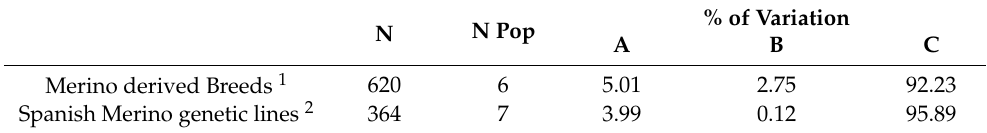
Table 2. Analysis of molecular variance (AMOVA) of the Merino-derived population using genomic data. A (% of Variation between Pop), B (% of Variation between samples within Pop), C (% of Variation within